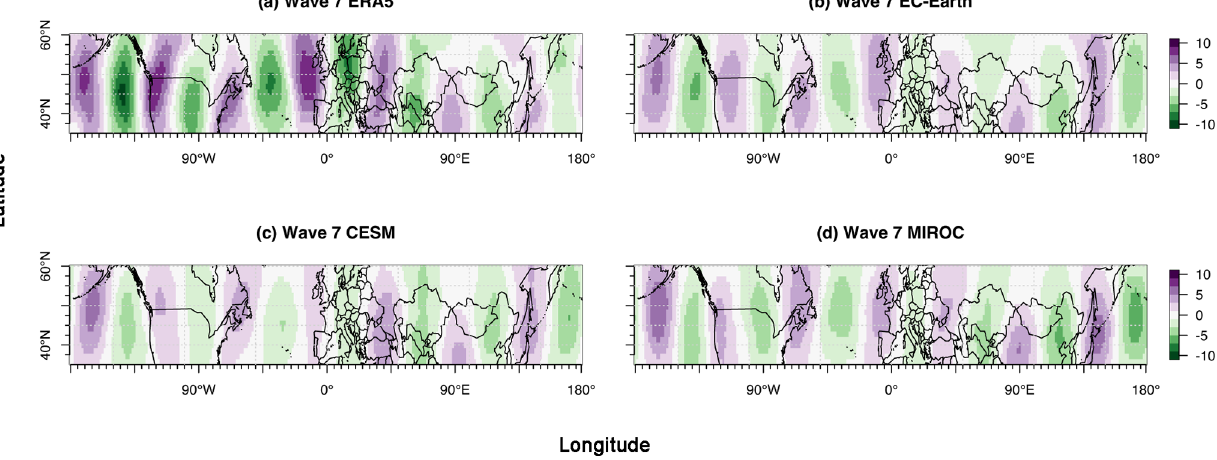
Weather Clim. Dynam., 3, 905–935, 2022